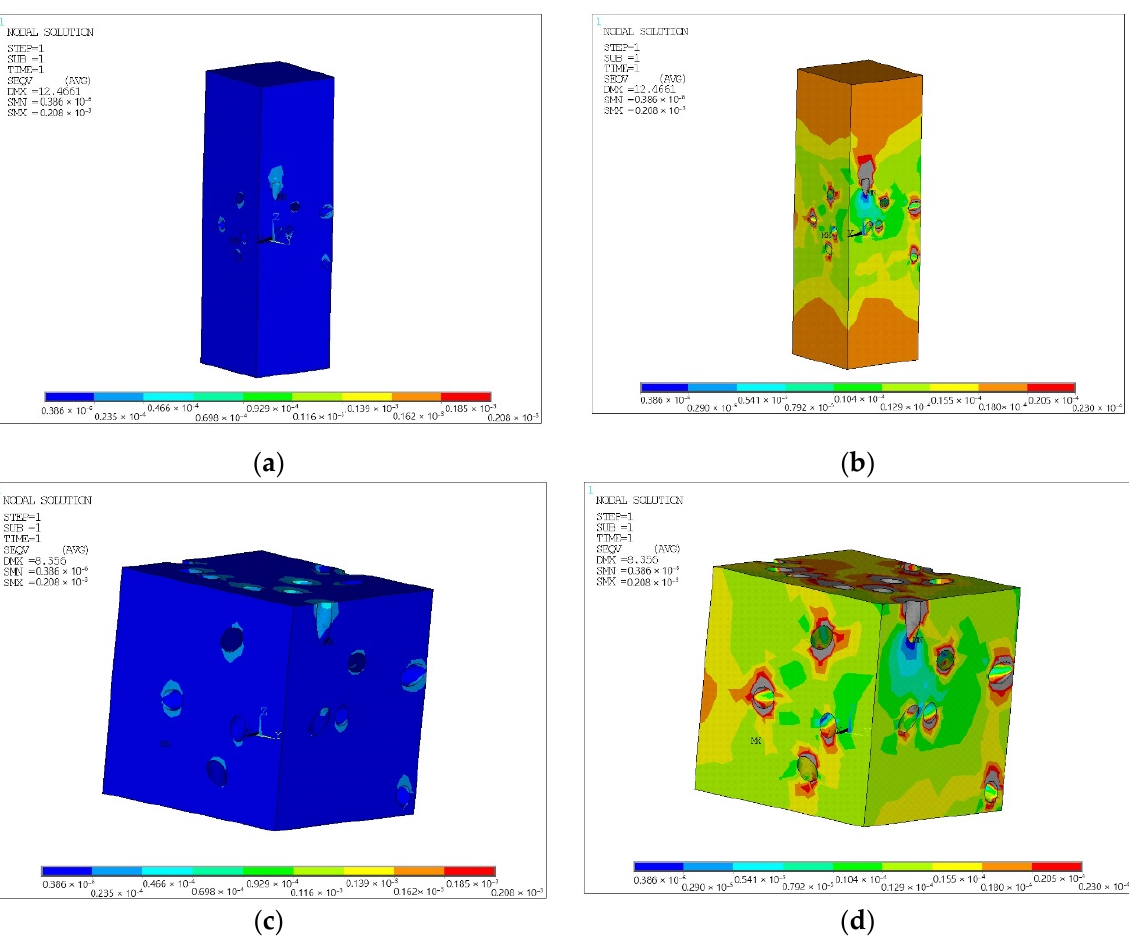
Figure 6. Equivalent von Mises stress for a matrix with a cylindrical filler, (10 − 6 MPa): ( a ) for the complete calculation model without restrictions on stress values; ( b ) for the complete calculation model with stress values up to the matrix strength limit of 20.8 MPa; ( c ) for the part of the calculation model that is saturated with fibers, without restrictions on the values of stresses; ( d ) for the part of the calculation model saturated with fibers, with stress values up to the matrix strength limit of 20.8